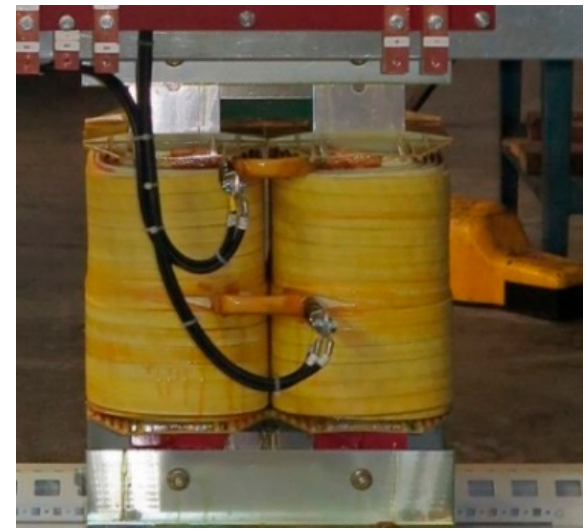
Figure 3. Inductor used in the charging station.